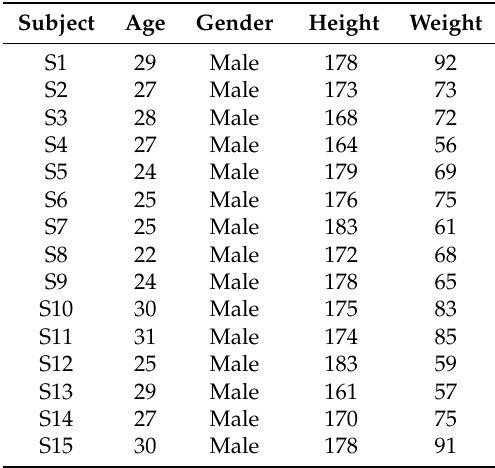
Table 1. Characteristics of the participants involved in the multimodal context mining study. The height is given in cm, while the weight is measured in